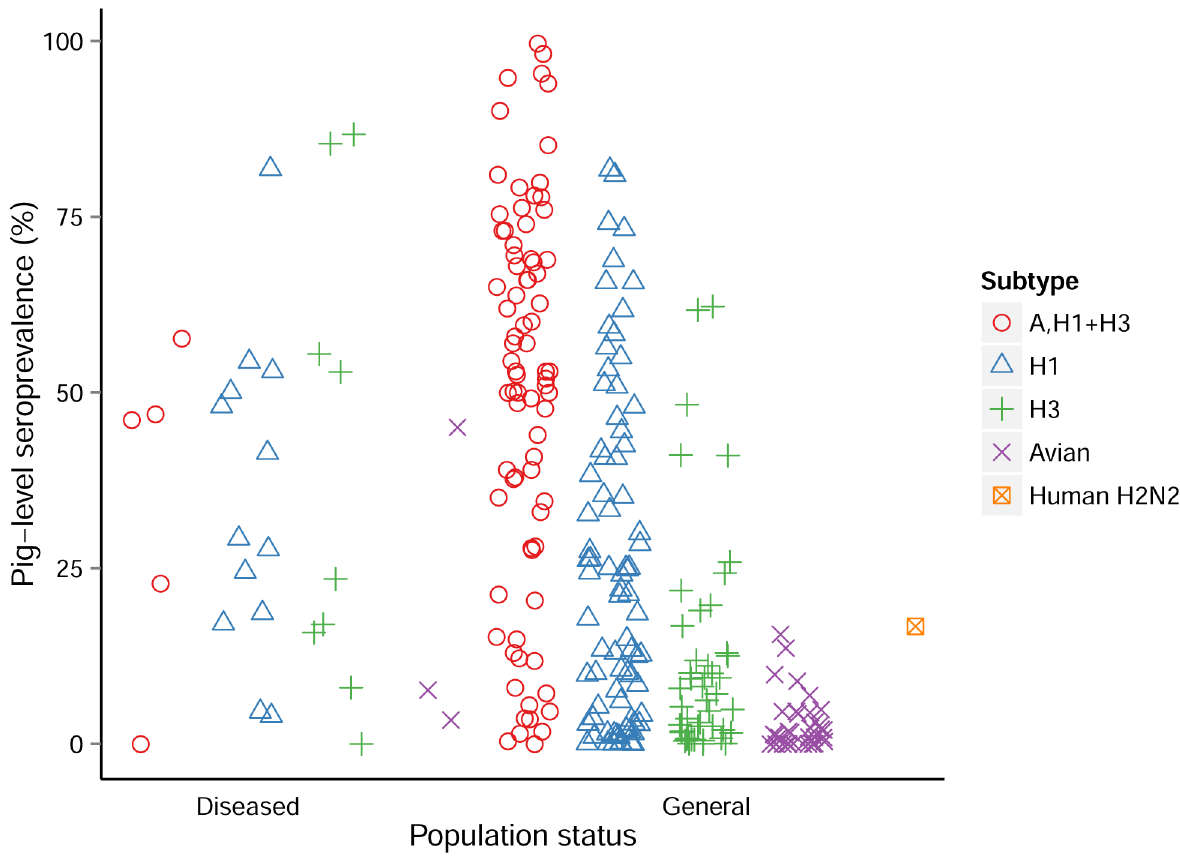
Fig 4. Pig-level seroprevalence distribution by health status and subtypes. N = 164 studies, 271